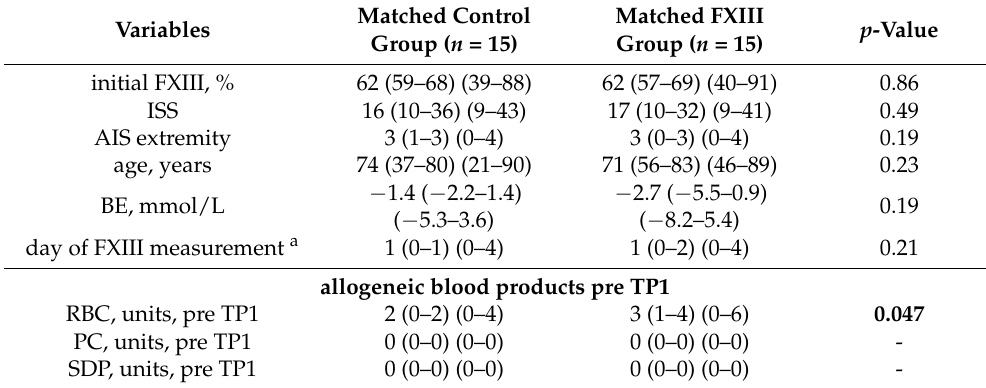
Table 3. Data of the matched-pair